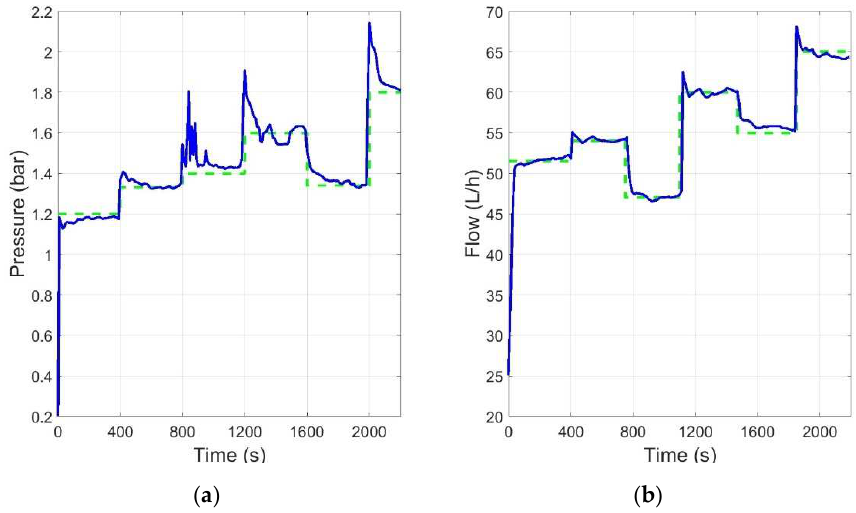
Figure 13. Controller performance (reference in green and output in blue): ( a ) change of the operating point for pressure; ( b ) change of operating point for flow.